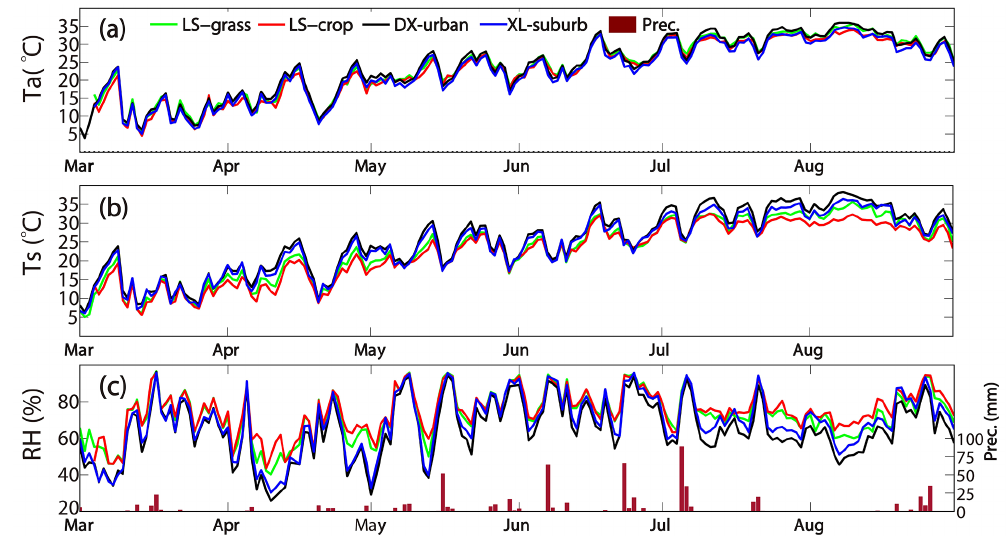
Figure 2. Daily variations in (a) air temperature, (b) surface temperature, and (c) relative humidity at the four sites in Nanjing from March to August